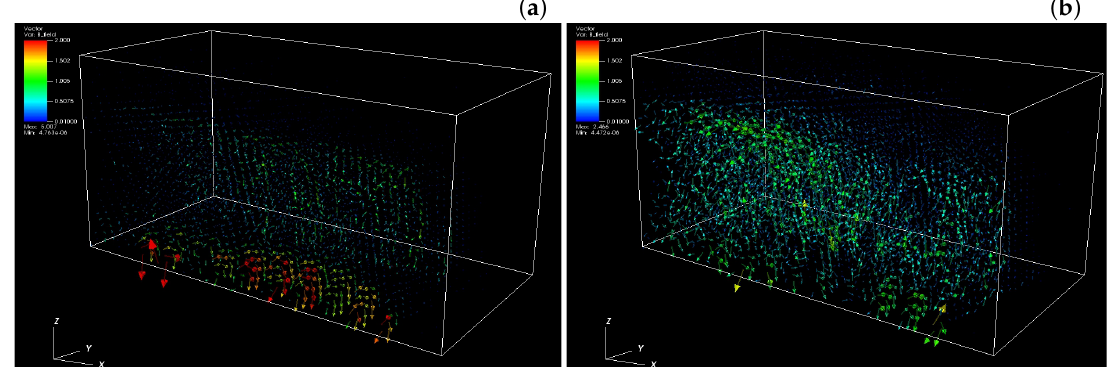
Figure 10. Panels show 3D vector plots of the magnetic fields for the ( a ) e − − p + and ( b ) e ± jets with r jet = 120 ∆ at time t = 500 ω − 1 pe . The colors show the strength of the magnetic fields in the quadrant of the front part of the